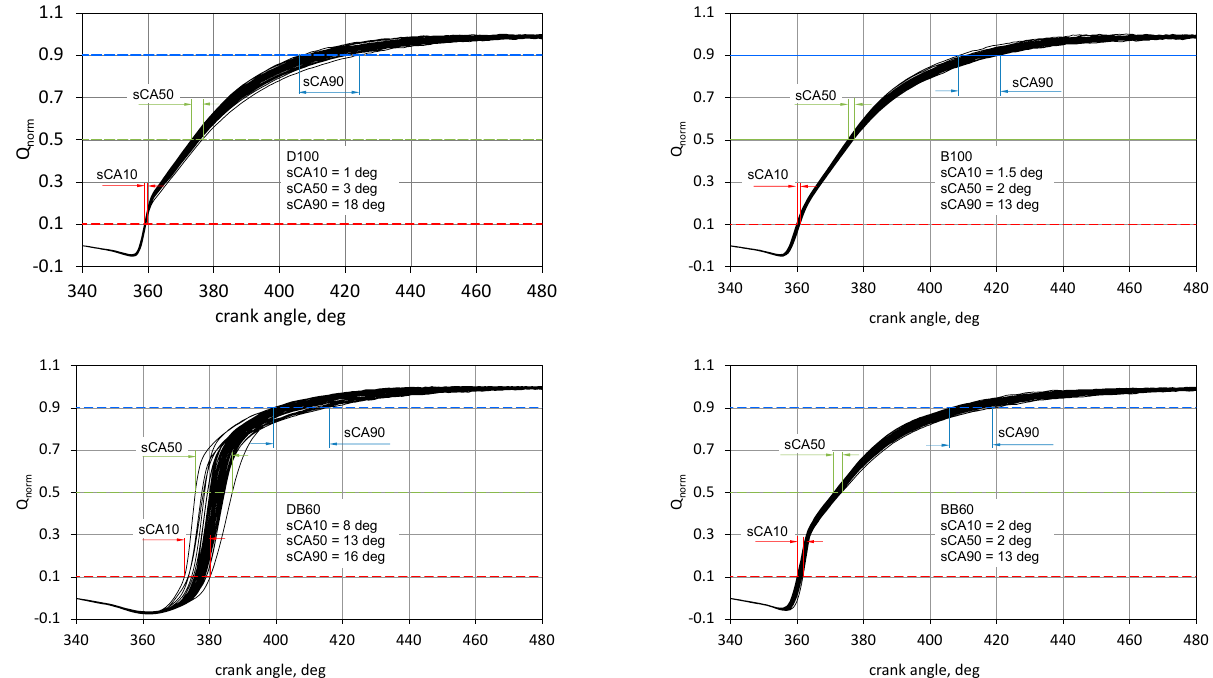
Figure 10. Spread the characteristic stages of combustion for DB, BB, and DB60 and BB60 fuel mixtures. Comparing the data for the engine powered by DB and BB, it can be seen that the spreads of the characteristic combustion stages are similar for both fuels, and for the engine powered by RME biodiesel there is a slightly higher repeatability of the cycles. CA90 spread was 5 deg smaller. Comparing the Q norm waveforms for the engine powered with 60% n-butanol content, the stability of the combustion stages has clearly shifted towards the engine powered by RME biodiesel. Detailed results of the assessment of the uniqueness of these combustion stages are presented in Figure 11.